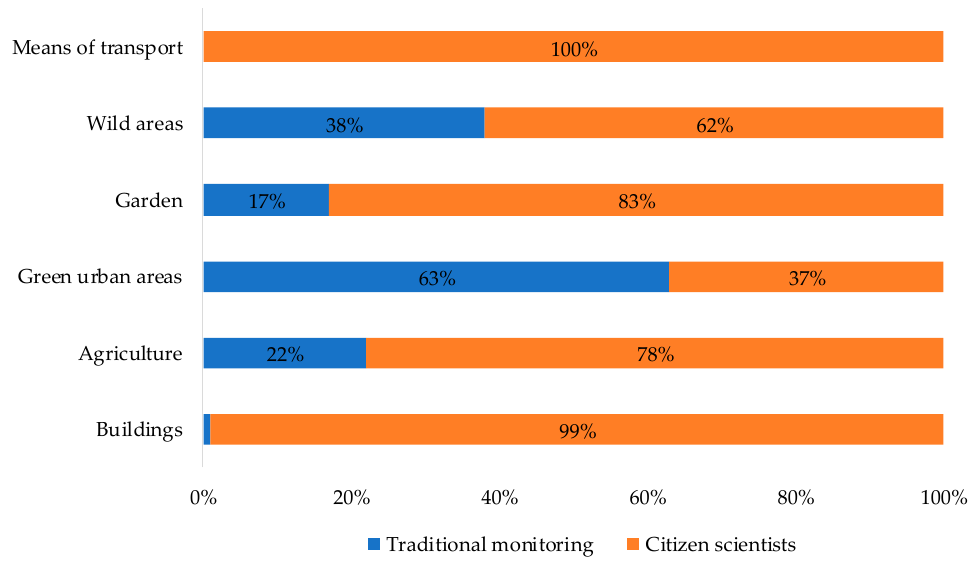
Figure 2. A representation of the different BugMap reports registered by citizens and those registered by technicians, adopting traditional monitoring methods (Pheromone traps, tree-beating). Blue bars: <10 specimens; orange bars: 10–15 specimens; grey bars: >50 specimens.